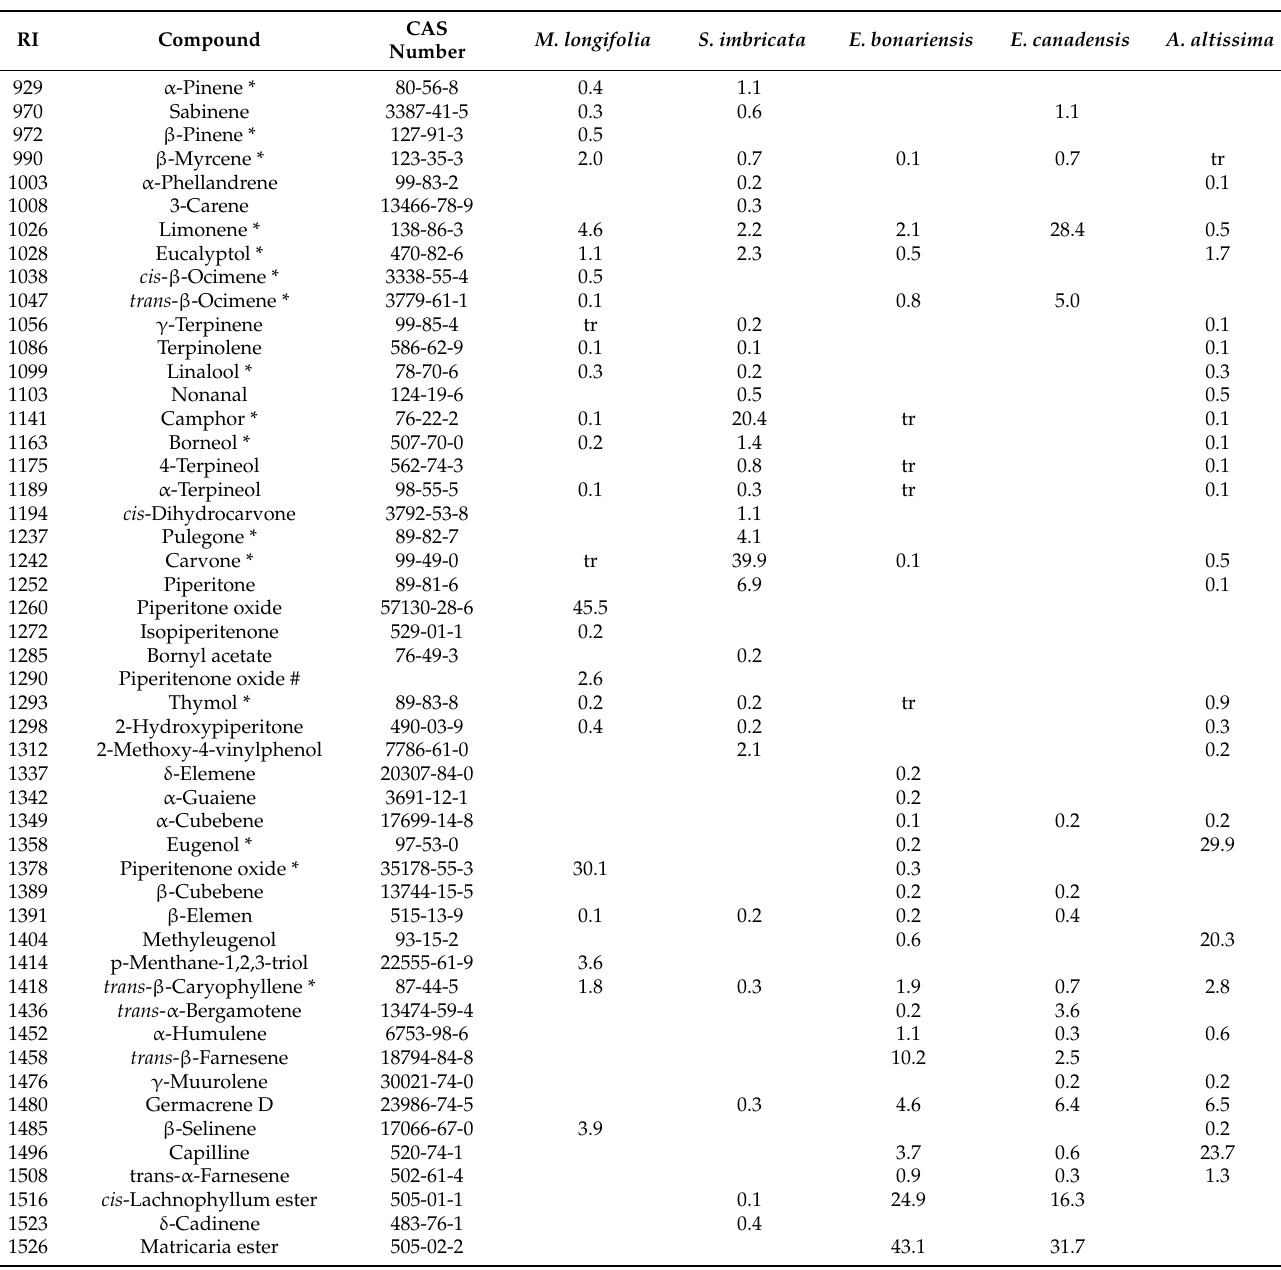
Table 3. Composition (expressed as %) of plant essential oils based on total ion chromatogram of